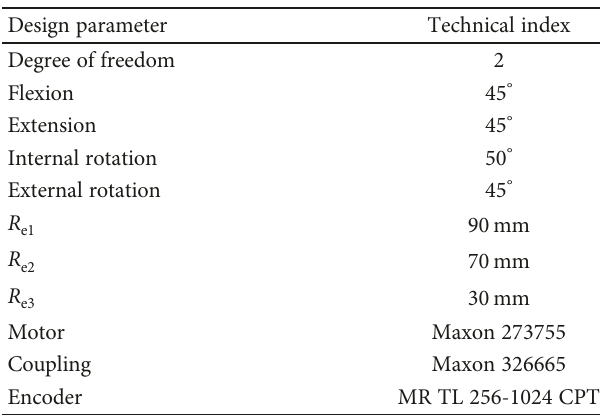
Figure 6: Probability distribution of the discrete histogram for the structure parameters for the biomimetic robotic elbow joint. Table 1: The primary technical parameters of the biomimetic robotic elbow